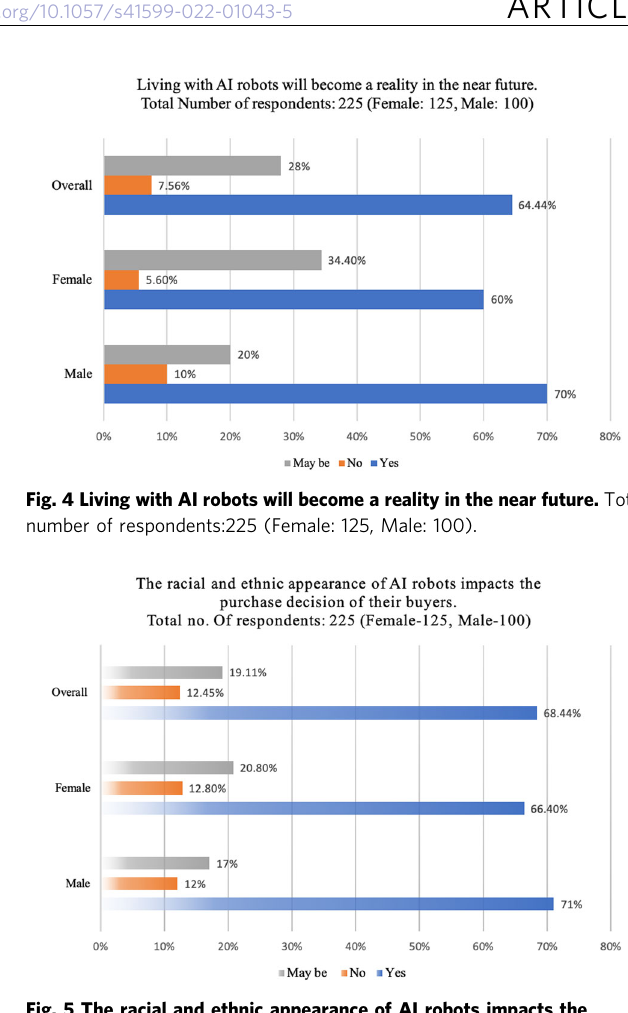
Fig. 5 The racial and ethnic appearance of AI robots impacts the purchase decision of their buyers. Total no. of respondents: 225 (Female: 125, Male: 100).